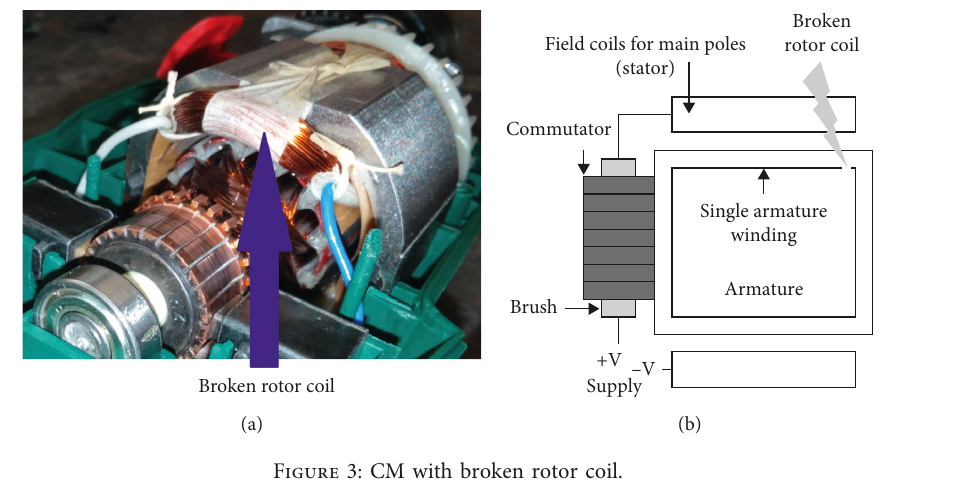
Figure 3: CM with broken rotor